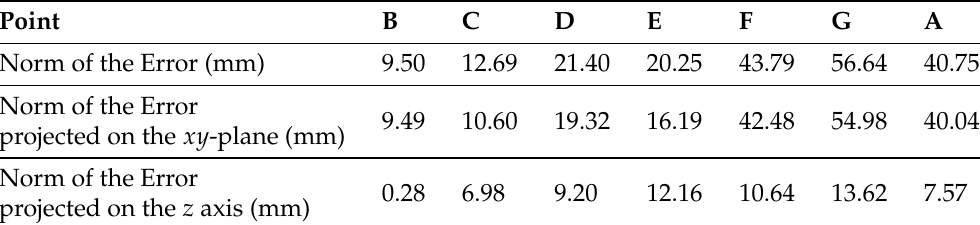
Table 4. Norm of the errors of the accuracy test performed on the link